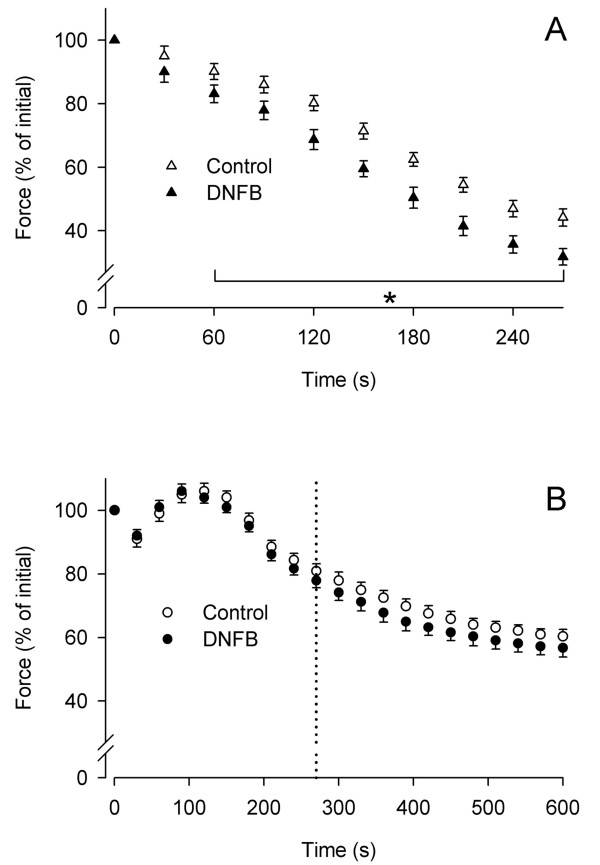
CK inhibition does not alter fatigue resistance of rat extraocular muscle. (A) DNFB (black triangles) decreases the fatigue resistance of EDL muscle bundles (n = 6 muscles per treatment, * P < 0.05 control vs. DNFB at the corresponding time points). (B) DNFB (black circles) does not accelerate fatigue development in extraocular muscles (n = 6 muscles per treatment). Vertical dotted line is included for comparison to mark to the end of the fatigue protocol for EDL muscles.